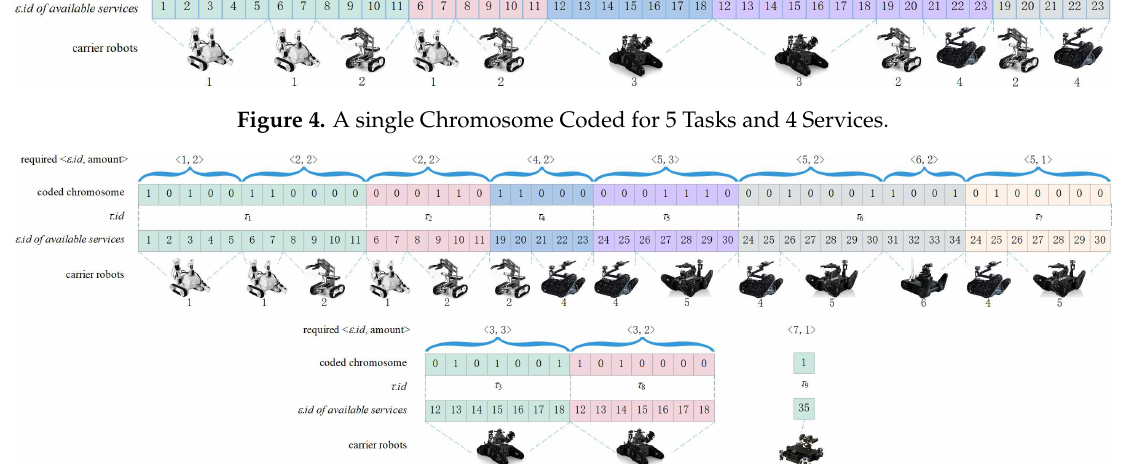
Figure 4. A single Chromosome Coded for 5 Tasks and 4 Services.